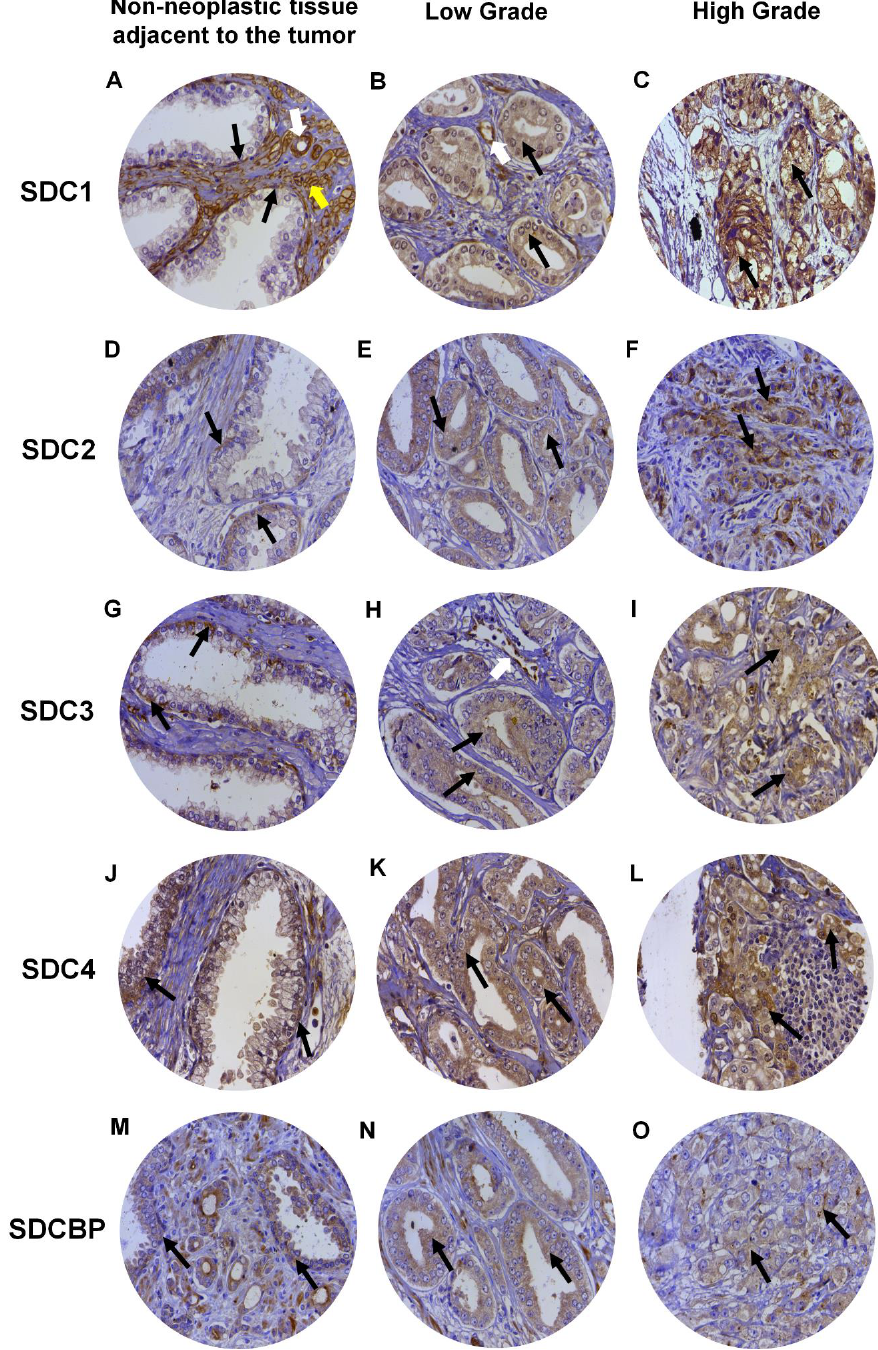
Figure 4. Representative images of immunohistochemical staining for SDC1, -2, -3, and -4, and SDCBP in adjacent non-neoplastic tissue ( I ), low-grade Gleason (Gleason grade 3), and high-grade Gleason (Gleason grades 4 or 5) from TMAs of human prostate samples. Images ( A – C ) show SDC1 staining. Images ( D – F ) show SDC2 staining. ( G – I ) show SDC3 staining. The ( J – L ) images show SDC4 staining. ( M – O ) images show SDCBP staining. Non-neoplastic tissue: ( A , D , G , J , M ). Low Grade: ( B , E , H , I , K ). High Grade: ( C , F , I , L , O ). Black arrows indicate positively stained cells. White arrows: blood vessels. Yellow arrow: smooth muscle cells. Final magnification: ×400. SDCBP expression in normal tissue, when positive, was present in the cytoplasm of In adenocarcinomas, when positive, SDC3 showed moderate immunostaining through- luminal and basal epithelial cells (Figure 4M). Positive immunostaining was detected for out the cytoplasm of neoplastic epithelial cells of patients with Gleason 3 tumors (Figure SDCBP in adenocarcinomas. SDCBP presented moderate immunostaining throughout the